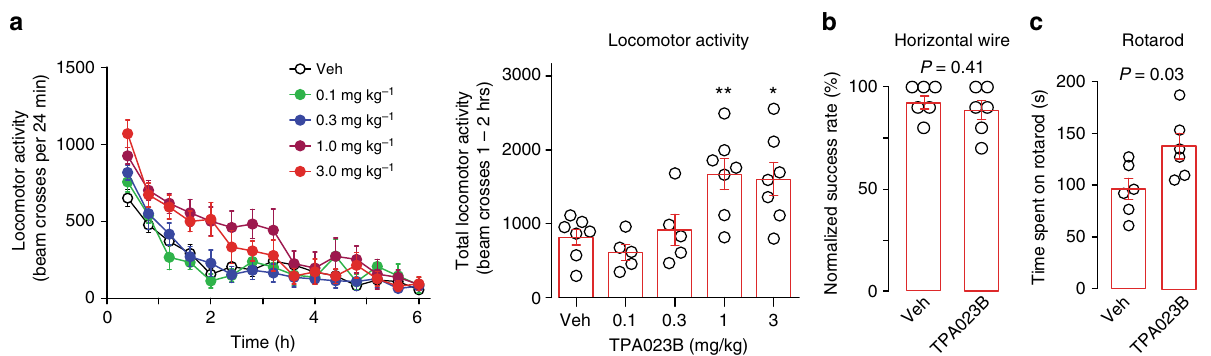
Fig. 5 In vivo pharmacological pro fi le of TPA023B. Behavioral effects of TPA023B in wild-type mice determined 1 – 2 h after p.o. drug administration. a Locomotor activity (number of beam crosses per time intervals of 24 min) was recorded for 6 h after TPA023B and plotted versus time after drug application. Statistical analysis of total number of beam crosses within the time interval 60 – 120 min. ANOVA followed by Dunnett ’ s post host test F(4,26) = 6.78. * P < 0.05; ** P < 0.01, n = 7, 6, 5, 7, 7 for vehicle, and 0.1, 0.3, 1, and 3 mg kg − 1 . b Muscle relaxation assessed in the horizontal wire test between 60 – 120 min after drug administration ( P = 0.41, unpaired two-sided t -test, n = 6 mice per group). c Motor coordination (rotarod performance)